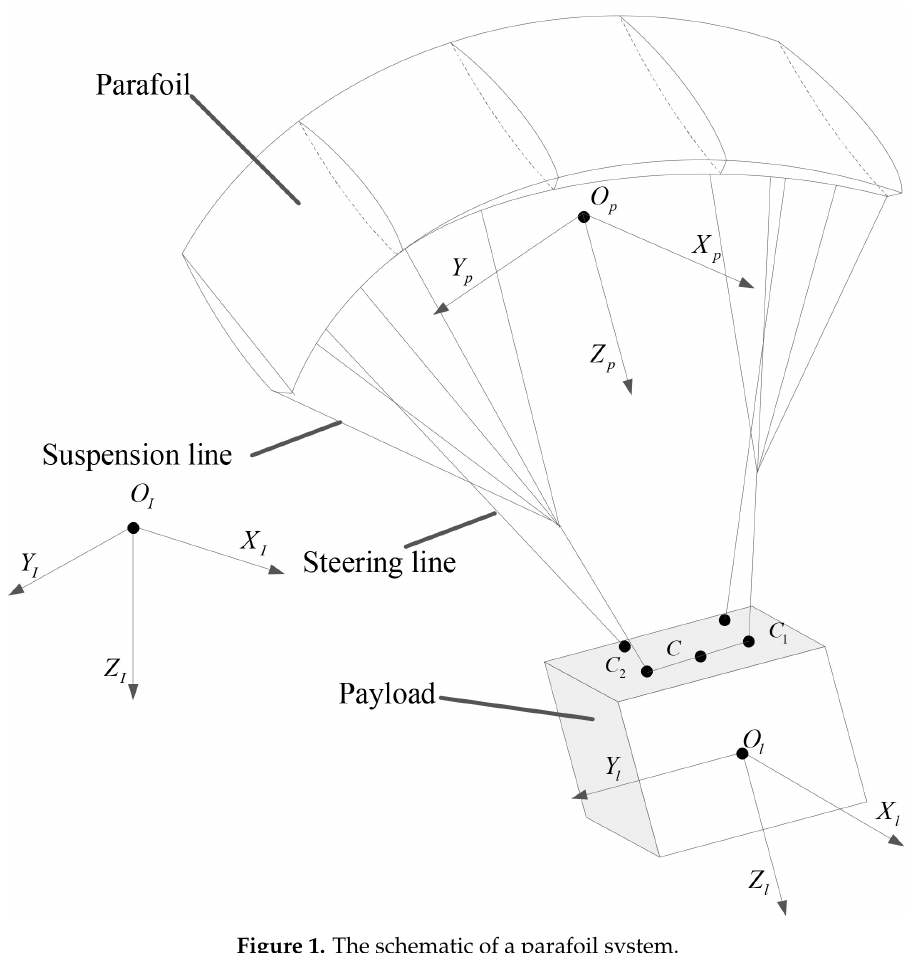
Figure 1. The schematic of a parafoil